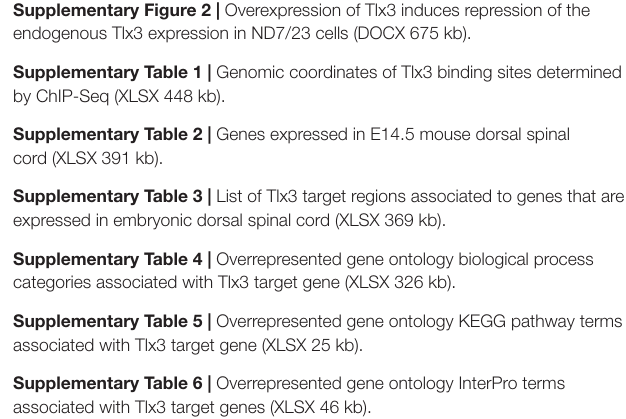
Supplementary Figure 1 | Pattern of H3K4me1, H3K4me3, and H3K27ac histone marks around Tlx3 peak summits in E14.5 mouse neural tube (DOCX 1461 kb).